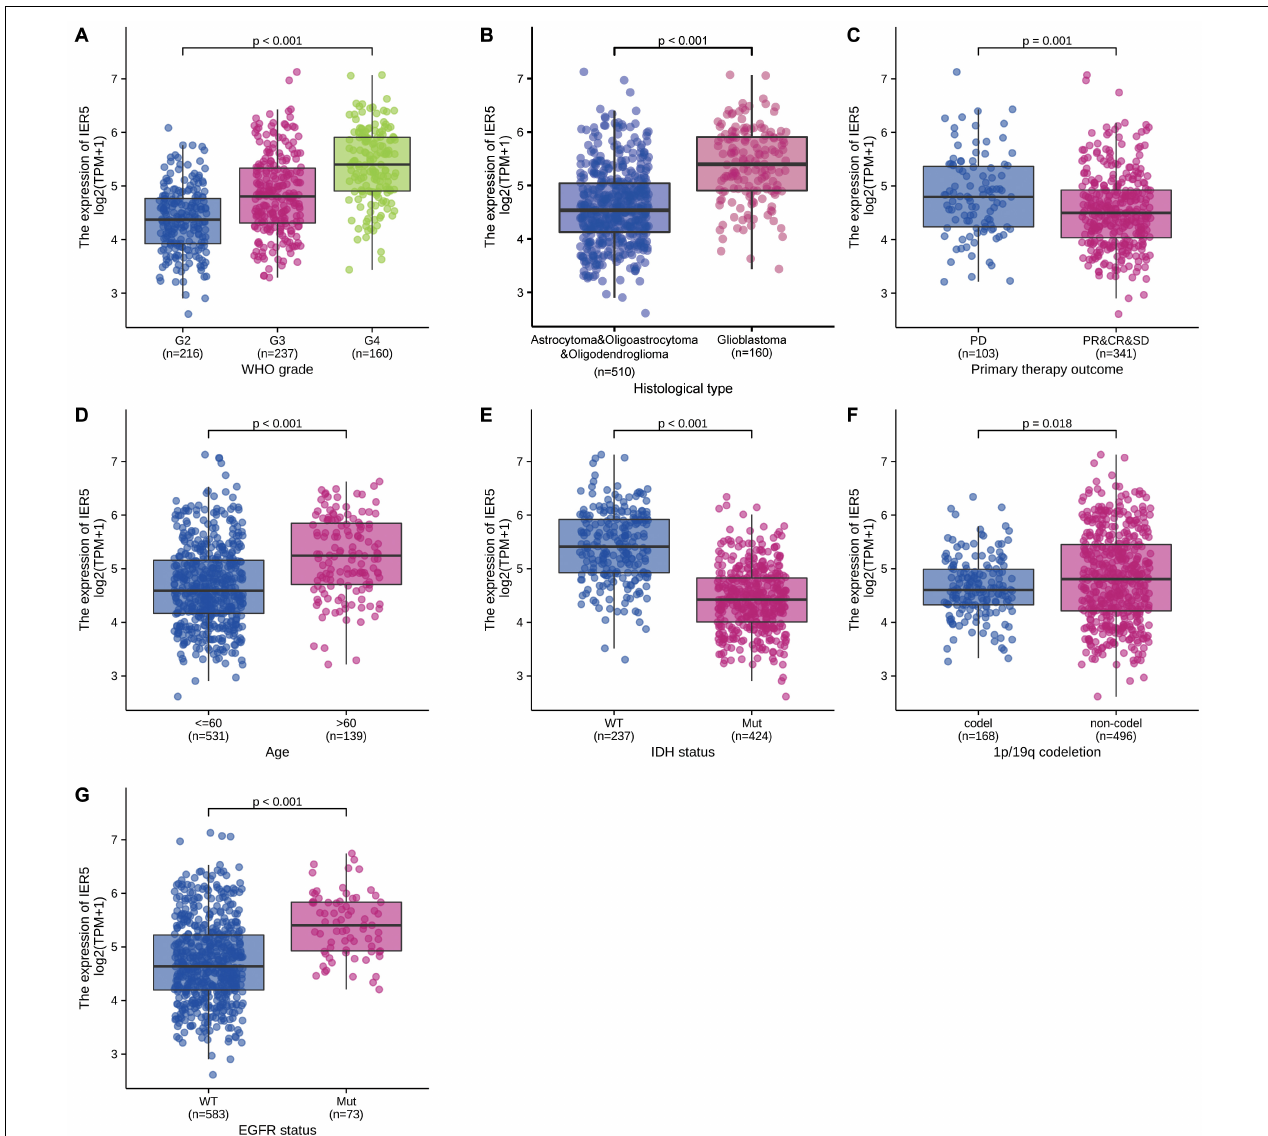
FIGURE 3 | Association of IER5 expression and clinicopathologic characteristics. (A) WHO grade, (B) Histological type, (C) Primary therapy outcome, (D) Age, (E) IDH status, (F) 1p/19q codeletion, and (G) EGFR status.